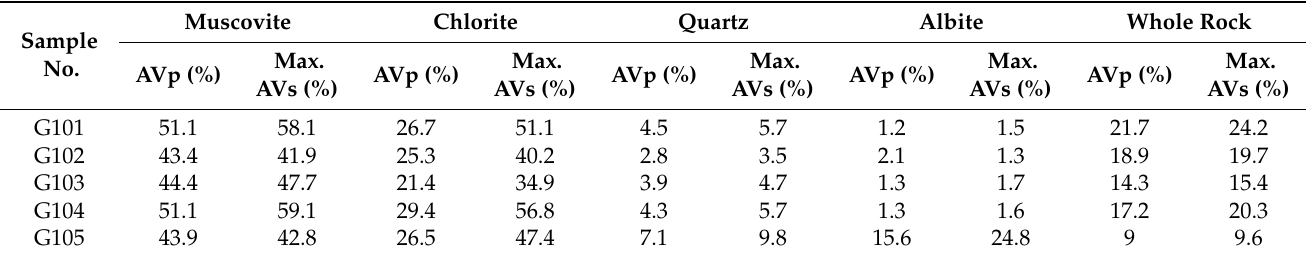
Table 3. Mineral and whole-rock Seismic velocity and anisotropy in phyllite